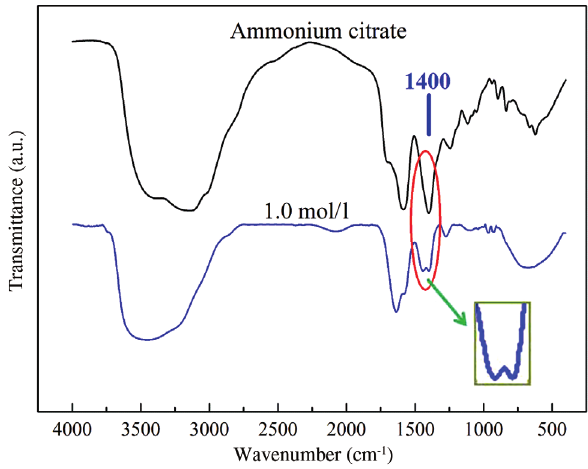
Figure 5: Fourier transform infrared (FT-IR) spectra of ammonium citrate (AC) solid and leaching liquids with the AC concentration of 1